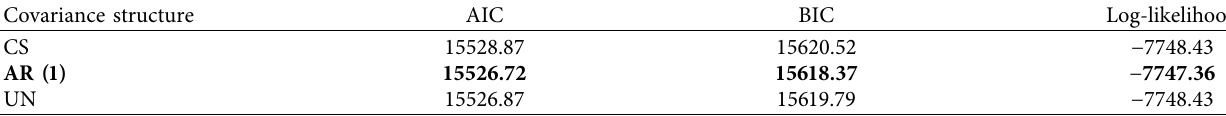
Table 3: Comparison of covariance structure for the linear mixed-effect model.